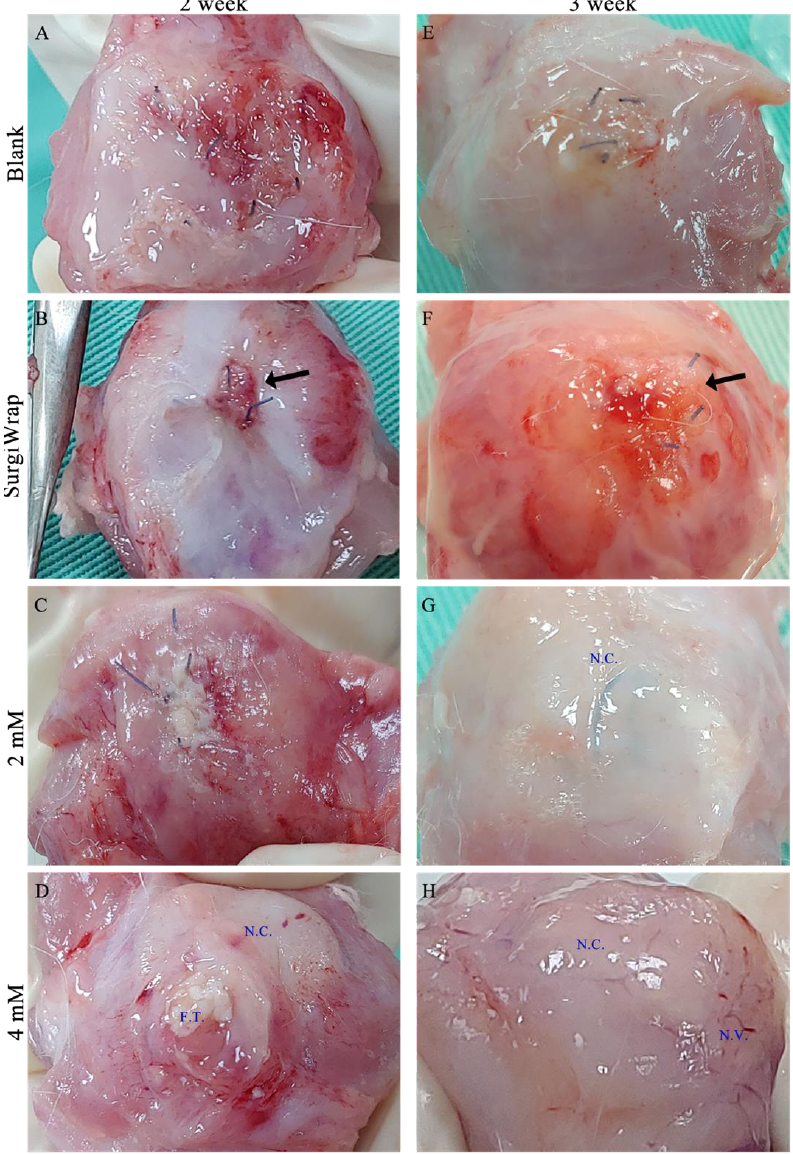
Figure 6. Gross observation of the RC tear after 2 weeks ( A : without membrane, B : covered with SurgiWarp, C : covered with 2 mM farnesol-impregnated membrane and D : covered with 4 mM farnesol-impregnated membrane) and 3 weeks ( E : without membrane, F : covered with SurgiWarp, G : covered with 2 mM farnesol-impregnated membrane and H : covered with 4 mM farnesol-im- pregnated membrane) of healing. Black arrows indicate sutured RC tears. RC: rotator cuff; F.T.: fi- brous issue; N.C.: newly generated connective tissue; N.V.: newly generated vessel.